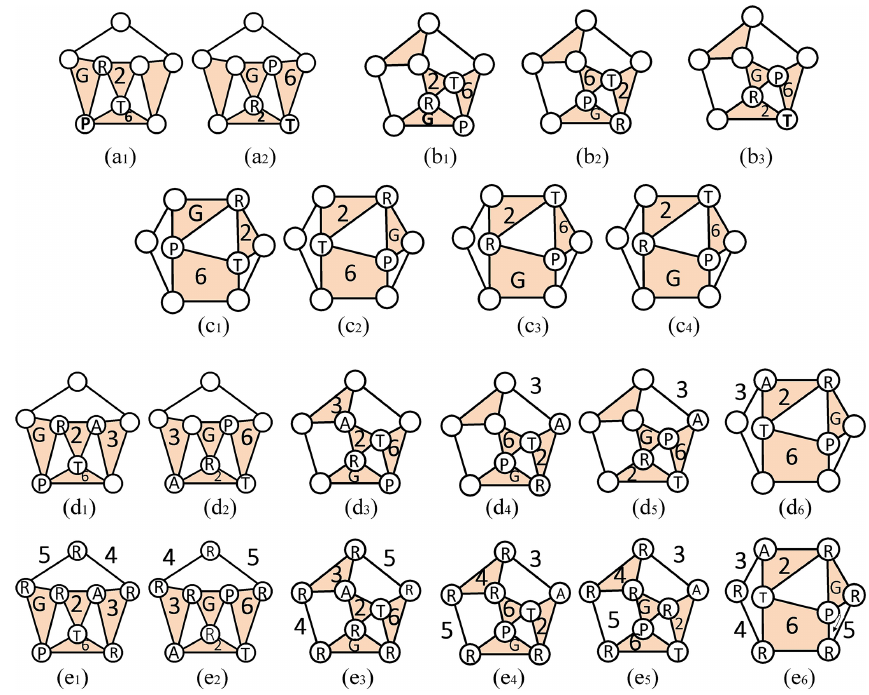
Figure 13. Specialized chains – model